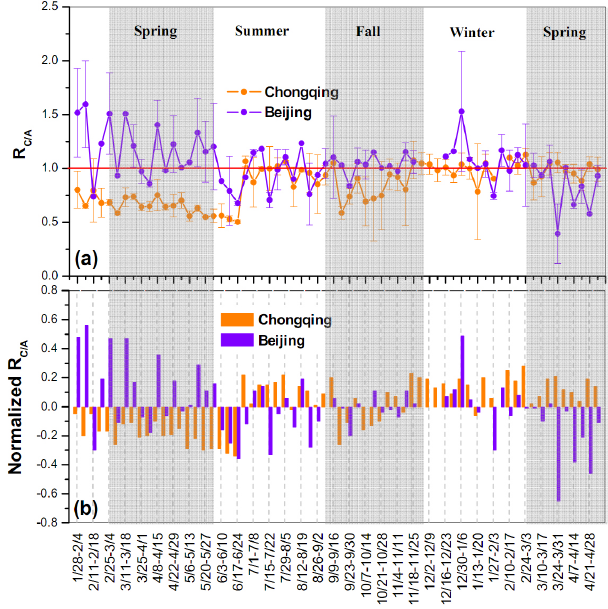
Fig. 1. Seasonal variations of (a) R C / A (uncertainty=standard deviation) and (b) normalized R C / A of PM 2 . 5 at Beijing and